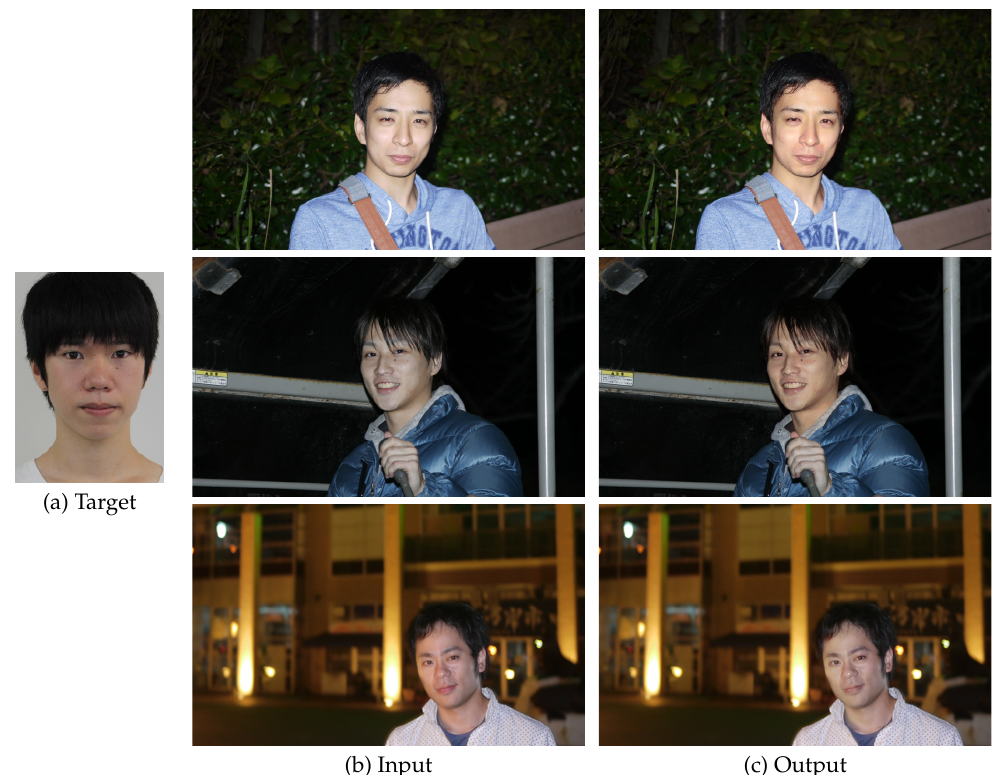
Figure 8. Our facial skin color correction on the flash images. ( a ) target facial skin color image; ( b ) input flash images; ( c ) output images using our facial skin color